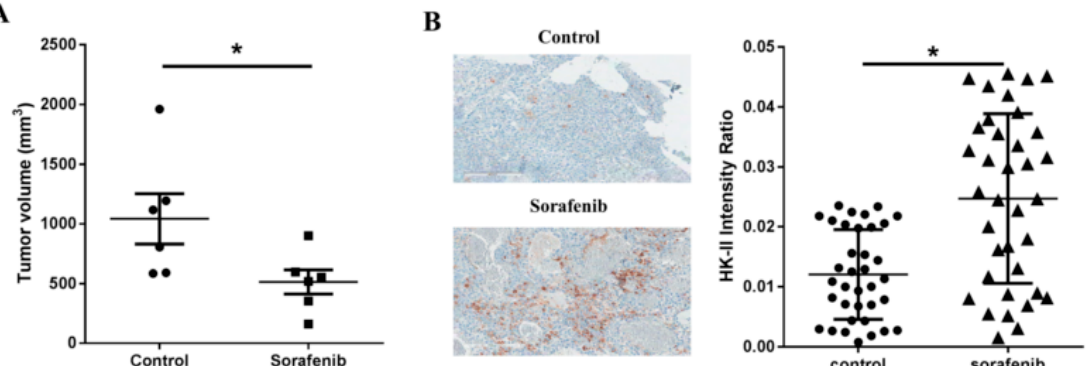
Figure 1. Sorafenib resulted in upregulation of hexokinase-II expression in hepatocellular carcinoma (HCC) tumors. ( A ) Murine subcutaneous HCC model of SNU-761 tumors. Sorafenib and/or 3-BP were administered two weeks after subcutaneous injection of SNU-761 cells ( n = 5, Mann-Whitney test, * p = 0.043); ( B ) hexokinase (HK)-II expression was analyzed by immunohistochemical staining of specimens from each experimental group. The expression of HK-II was significantly lower in the tumors of mice receiving sorafenib + 3-BP than in the tumors of mice receiving sorafenib alone ( n = 5, Mann-Whitney test, * p < 0.0001).